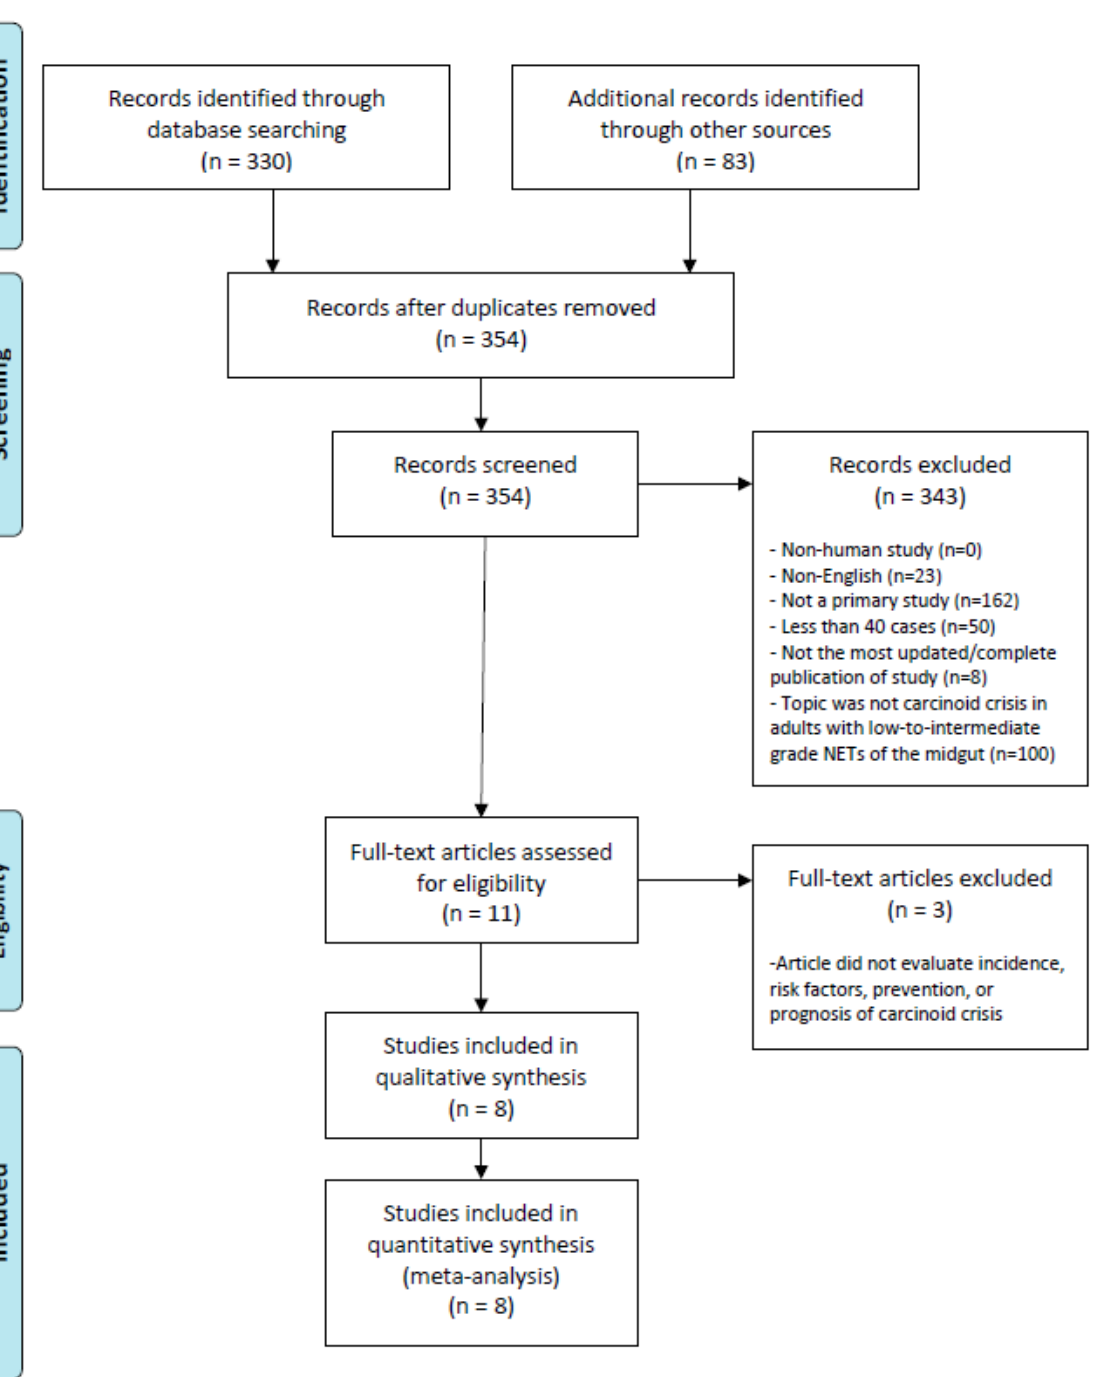
Figure A2. PRISMA flow diagram for study selection .